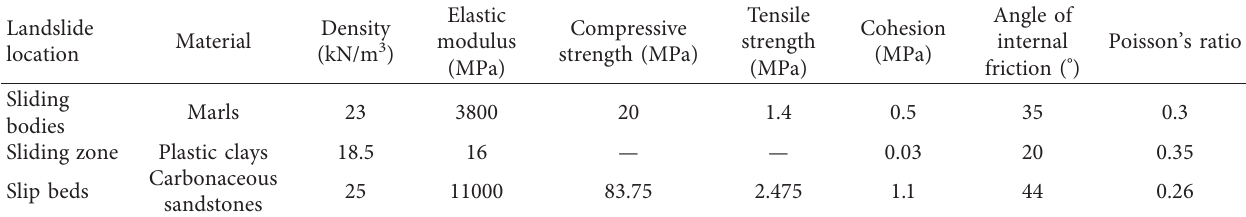
Table 1: The mechanical parameters of the geotechnical landslides.